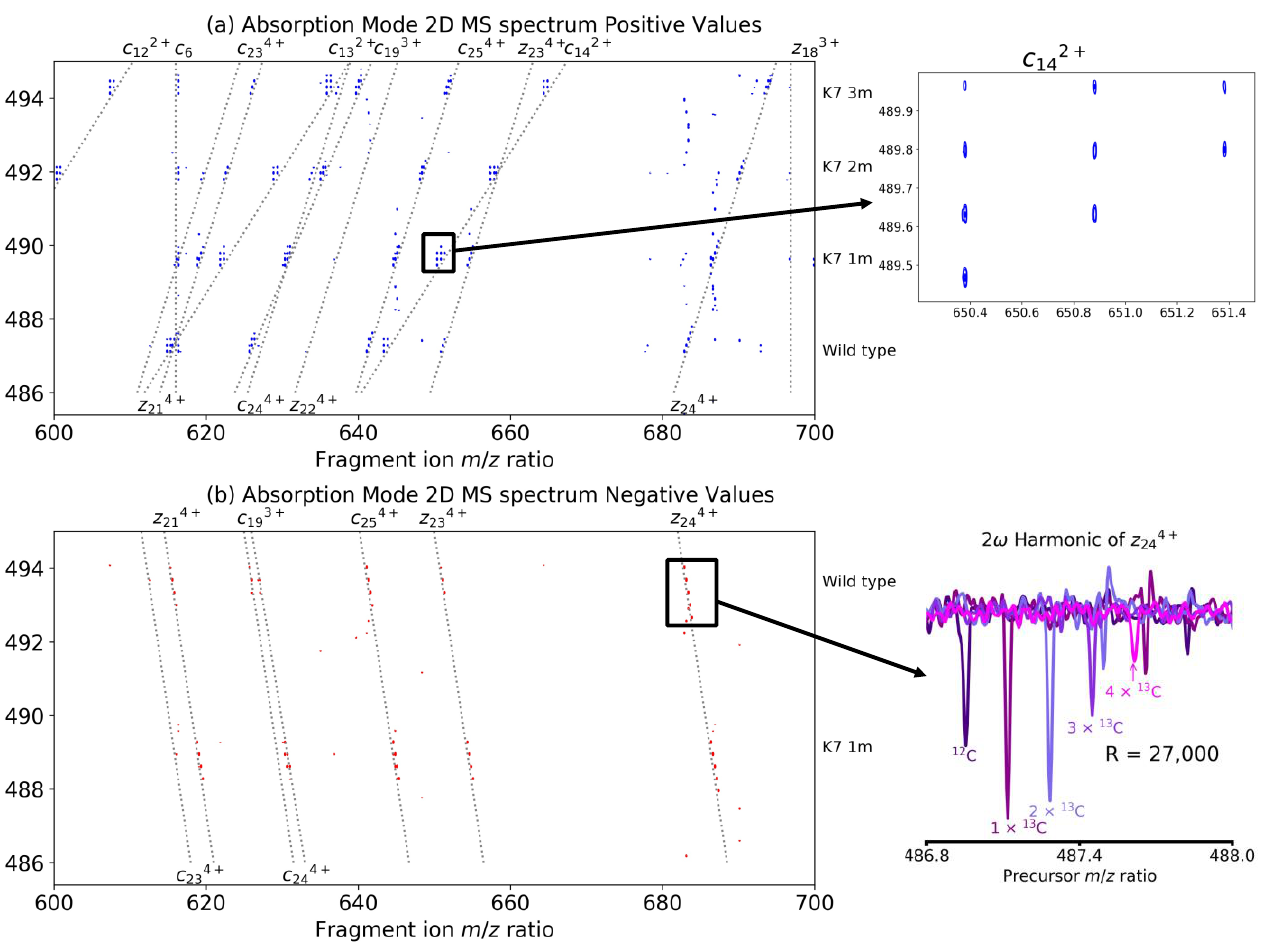
Figure 4. Phase-corrected absorption mode 2D mass spectrum of histone peptides, zoomed in between m/z 600-700 horizontally and m/z 485-495 vertically, ( a ) positive values plotted (insert: zoom-in on the isotopic distribution of the c 142+ fragment of the methylated histone peptide) and ( b ) negative values plotted (insert: vertical precursor ion scans of the isotopic distribution of z 244+ of the unmodified histone peptide, with frequency-to-mass conversion for the 2ω harmonic).